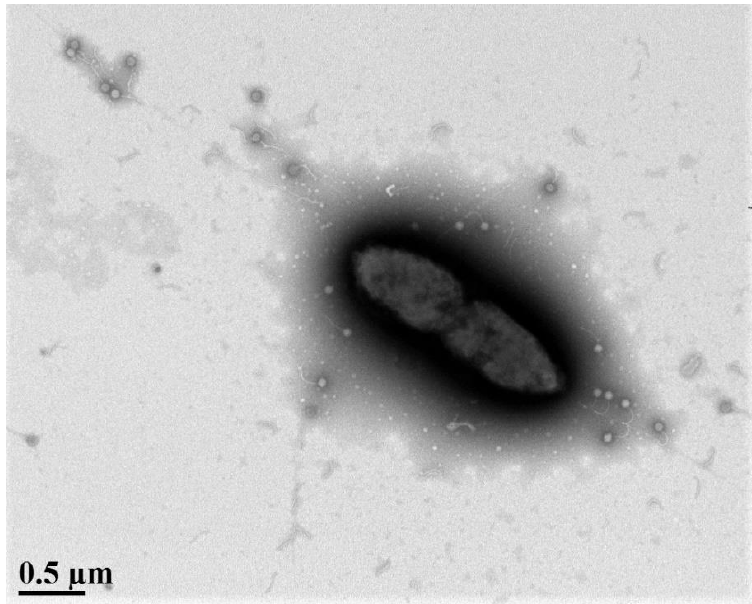
Figure 1. Transmission electron micrograph of S. maltophilia cell attacked by phages. S. maltophilia strain D1585 with numerous DLP1 bacteriophage [11] virions binding to type IV pili that are protruding from the cell. Cells and phages were stained with 2% phosphotungstic acid and visualized at 18,000-fold magnification by transmission electron microscopy (McCutcheon, J. G. and Oatway, A.; University of Alberta).